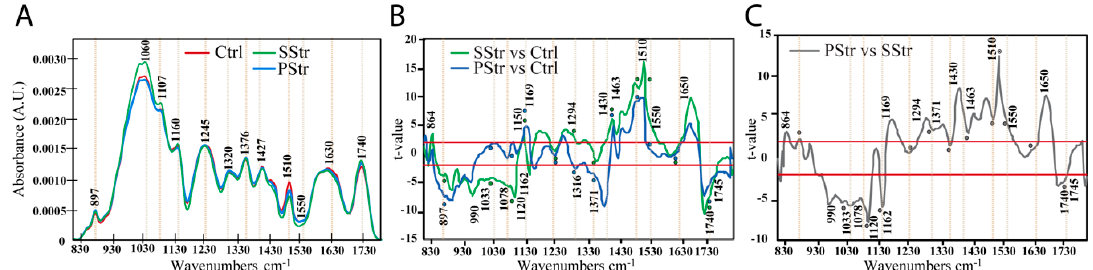
Figure 7. Secondary cell wall (SCW) composition of the stem of plants under high salinity. ( A ) Average FT-IR spectra obtained on the xylem of Ctrl, PStr and SStr plants. Maxima are indicated above the curves. A.U.: arbitrary units. In ( B , C ), t -values from Student’s t -test of pairwise comparisons between absorbances are shown: PStr versus Ctrl (black line), SStr versus Ctrl (green line) in ( B ) and SStr versus PStr(greyline)in( C ).Theredlinesareat t =+ 2: t -valuesbelow − 2orabove − 2correspondtosignificantly stronger and weaker absorbances respectively ( p < 0.05). Data between the red lines ( − 2 and + 2) correspond to non-significant di ff erences between the di ff erent conditions. In ( B , C ): Maxima identified on ( A ) are reported as circled dots on the curves. Spectral wavenumbers for cellulose (1033, 1060, 1120 and 1162 cm − 1 ) [54,55], cellulose and hemicellulose vibrations (864, 897 and 1169 cm − 1 ) [54–57], xyloglucan (945, 1078, 1316 and 1371 cm − 1 ) [54,57], acetylated xylans (1740 cm − 1 ) [58,59], other polysaccharides linkages (990, 1150 and 1294 cm − 1 ) [54,56], esters (1745 cm − 1 ) [55], lignins (1430, 1463 and 1510 cm − 1 ) [60,61] and amides I and II (1550 and 1650 cm − 1 ) [61] are reported above or below the curves in ( B ) and ( C